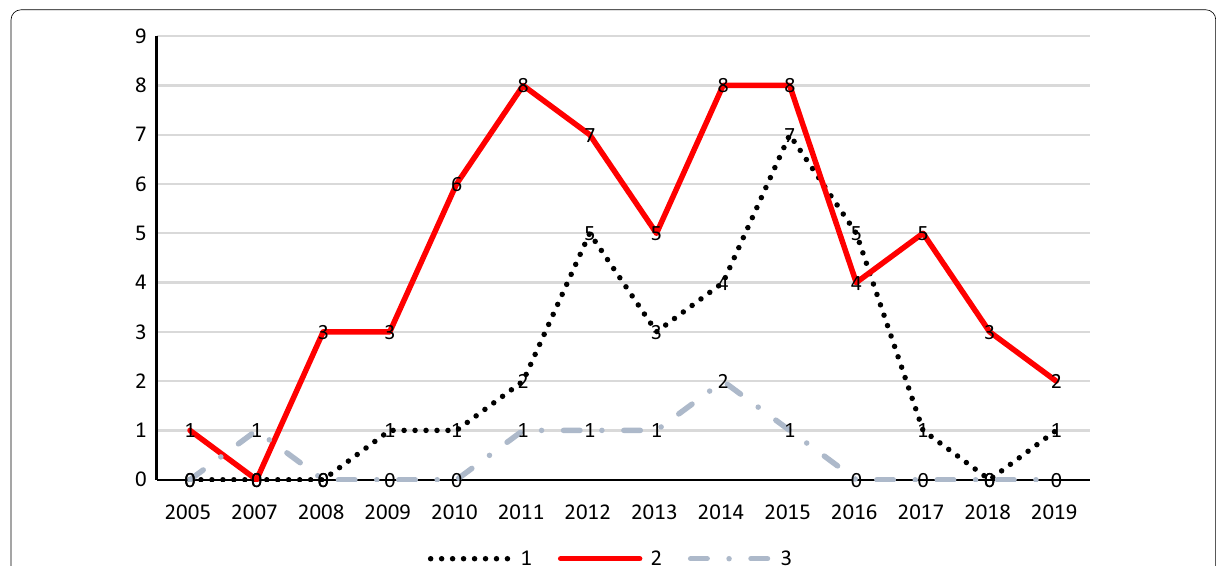
Fig. 9 Distribution of highly cited publications by school level focus and year. (Note: 1